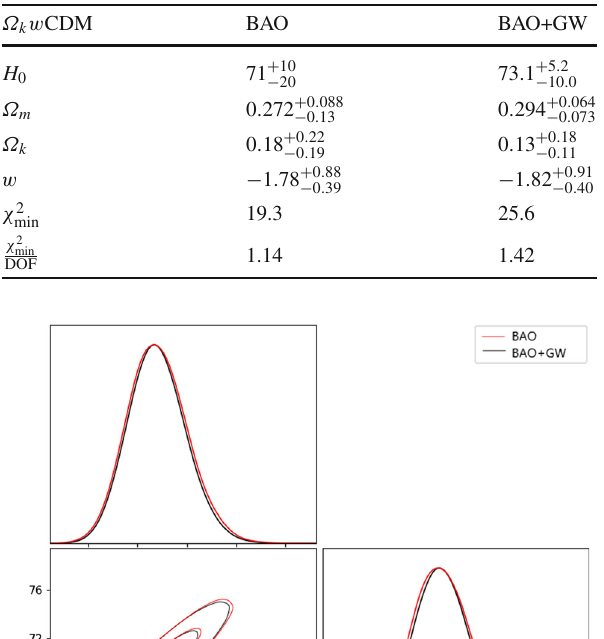
Table 4 The 68% CL constraints on the independent parameters of the Ω